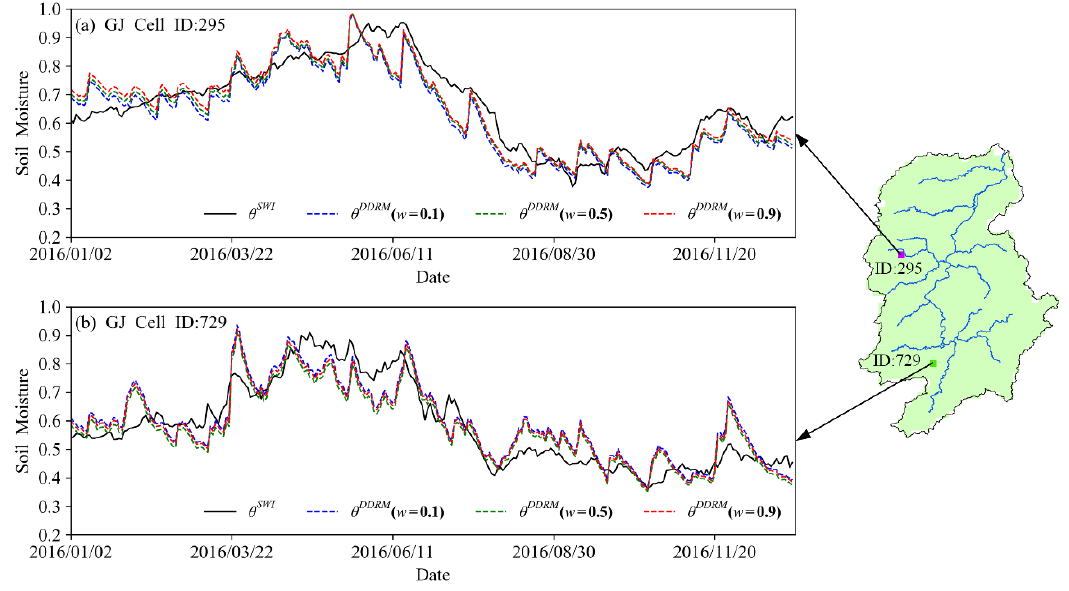
Figure 10. Temporal comparison of cell-based SWI series ( 𝜃 𝑖𝑆𝑊𝐼 ) and DDRM-simulated soil moisture series ( 𝜃 𝑖𝐷𝐷𝑅𝑀 ) for GJ. Two cells ( a ) cell ID 295 and ( b ) cell ID 729 are shown here for illustration purposes.